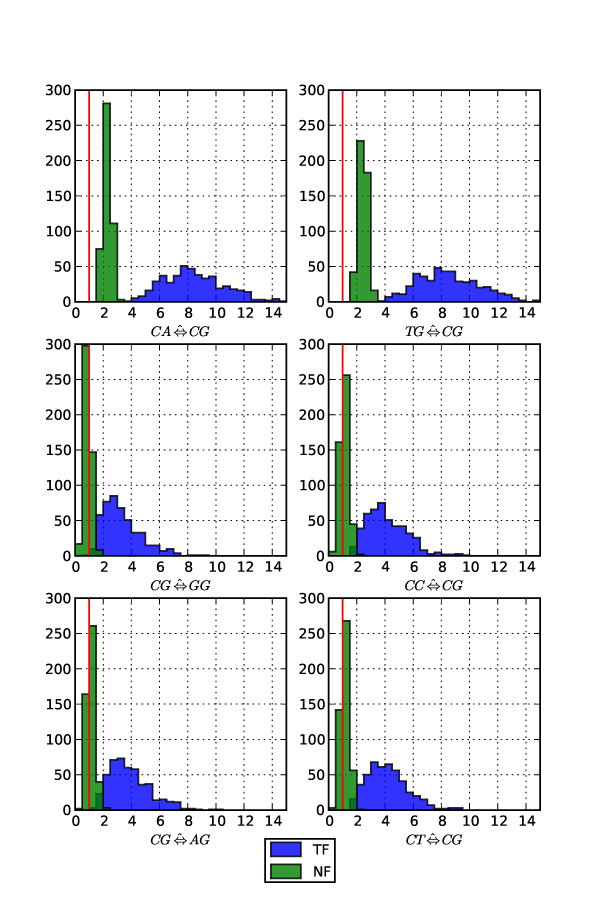
CpG substitution rate MLEs were discordant between TF and NF. The MLEs were those used to calculate the means in Figure 3. The vertical red line corresponds to the expected value under the null hypothesis (the parameter has no effect).